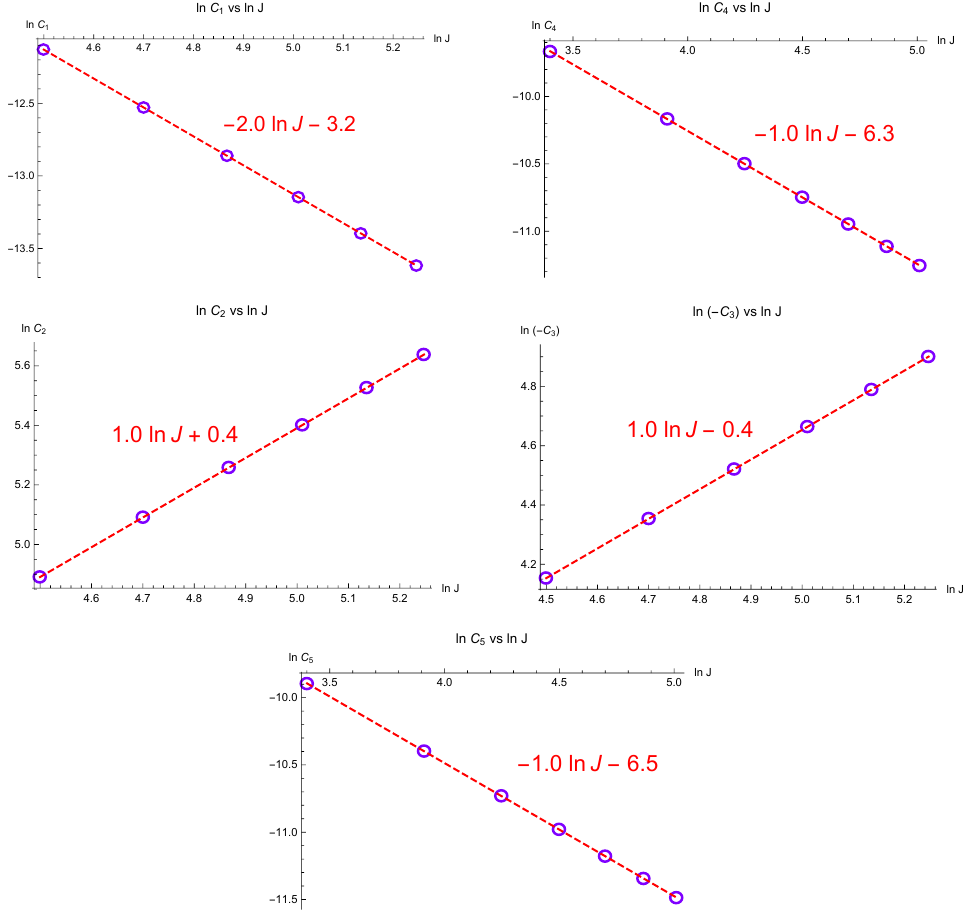
Figure 3 . Numerical plots of ln j C k j versus ln J , along with the linear (cid:12)ts. We take modestly large values of J ranging from 30 to 200, yet we are able to identify robust power law behavior.